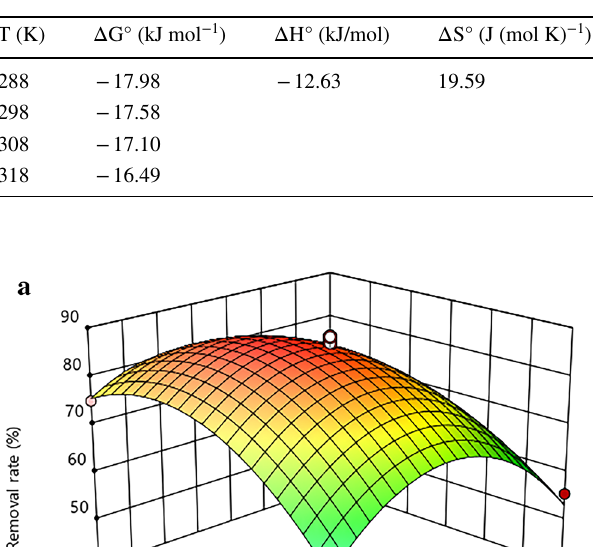
Table 8 Thermodynamics parameters for MNZ sorption onto S. plat- ensis